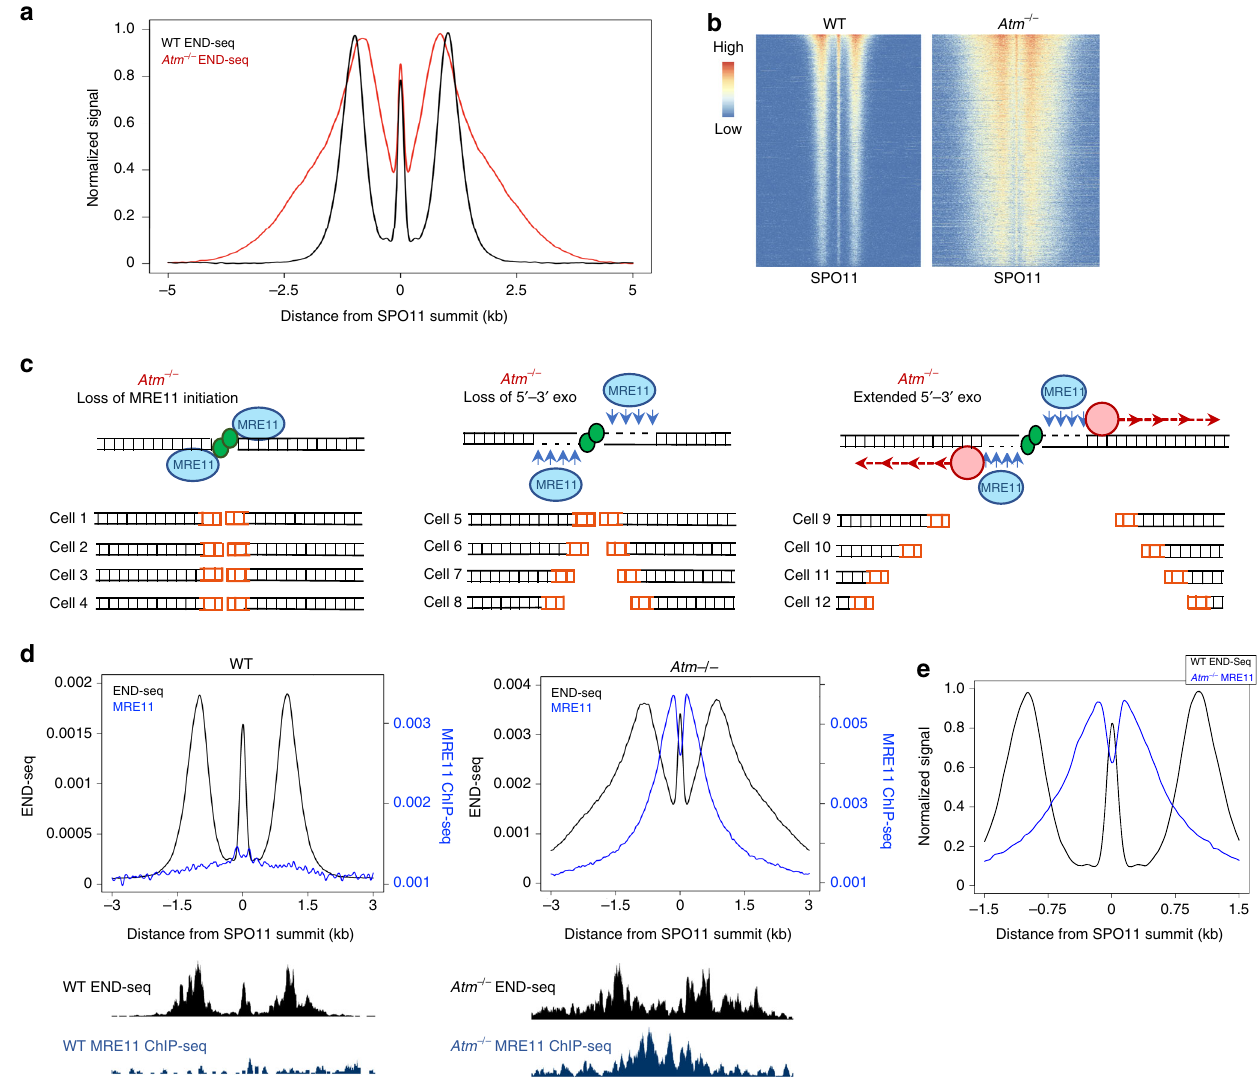
Fig. 5 ATM coordinates multiple levels of resection machinery. a Aggregate plots of END-seq signal in WT vs Atm – / – at top 5000 WT breaks around SPO11-oligo summits. Signals are normalized to the same height for DSB pattern clarity. b Heatmaps of WT and Atm – / – END-seq ± 5 kb around SPO11-oligo summits for top 5000 WT hotspots. Signals are normalized to spike-in control to show increased Atm – / – break intensity per hotspot. c Illustrations of ATM ’ s multiple roles in coordinating resection that gives overall heterogeneous END-seq pattern in a . Left: MRE11 is recruited yet not activated in a subset of cells, resulting in reads directly at SPO11 DSB within the population. Middle: MRE11 is activated in another subset of cells, yet long-range resection is not suf fi ciently initiated, resulting in reads from only MRE11 nicking, and perhaps 3 ′ − 5 ′ exonuclease activity, fl anking the DSB in regions that are read-less in WT. Right: resection is properly initiated in another subset of cells, yet long-range resection travels signi fi cantly farther than in WT. d Aggregated END-seq signal and MRE11 ChIP-seq RPM in WT (left) and Atm – / – (right). To fairly compare ChIP-seq signal between WT and Atm – / – , MRE11 scale is proportional to spike-in normalized END-seq RPM for each genotype. Individual hotspot examples (chr12:34,592,264-34,598,265) are shown below. Note that decreased MRE11 coverage is observed within NDR of Atm – / – . e Aggregate plot overlapping WT END-seq and Atm – / – MRE11 ChIP-seq, normalized to the same height. MRE11 shows prominent localization to the WT END-seq read-less